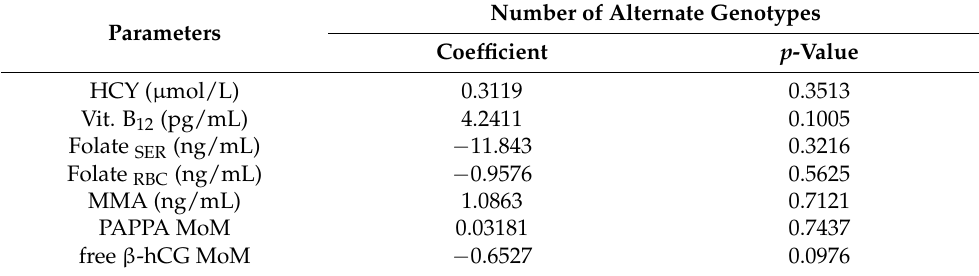
Table 8. Assessment of the relationship between changes in the concentrations of the tested biochem- ical parameters and the number of alternative genotypes of the variants of the studied genes in both the hetero- and homozygous systems based on a regression model analysis.